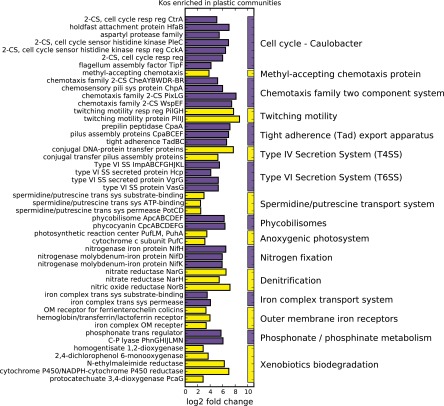
Selected KEGG genes that were significantly more abundant (>2 log2-fold change; FDR-adjusted P < 0.005) in plastic-associated metagenomic libraries than in the picoplankton community in the surrounding water column. Some gene-encoded products with related functions have been condensed, and the log2-fold change has been averaged (e.g., phnGHIJLMN). For a list of all of the KEGG genes identified in this study and a list of the KEGG genes and descriptions included here, see Data Set S1 in the supplemental material. Abbreviations of gene product descriptions: 2-CS, two-component system; resp reg, response regulator; OM, outer membrane; SS, secretion system; sys, system; trans, transport.